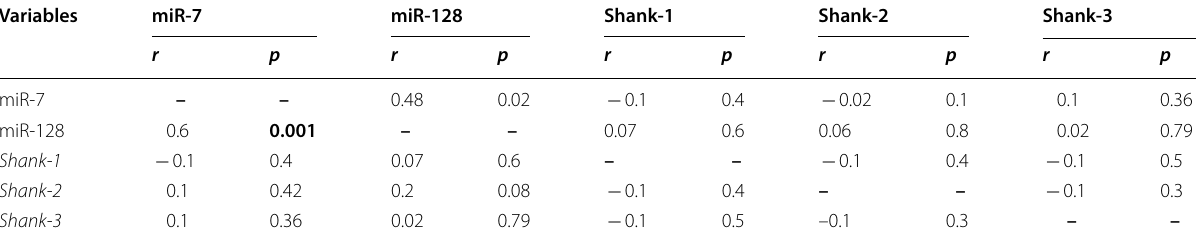
The bold format represents the significant p